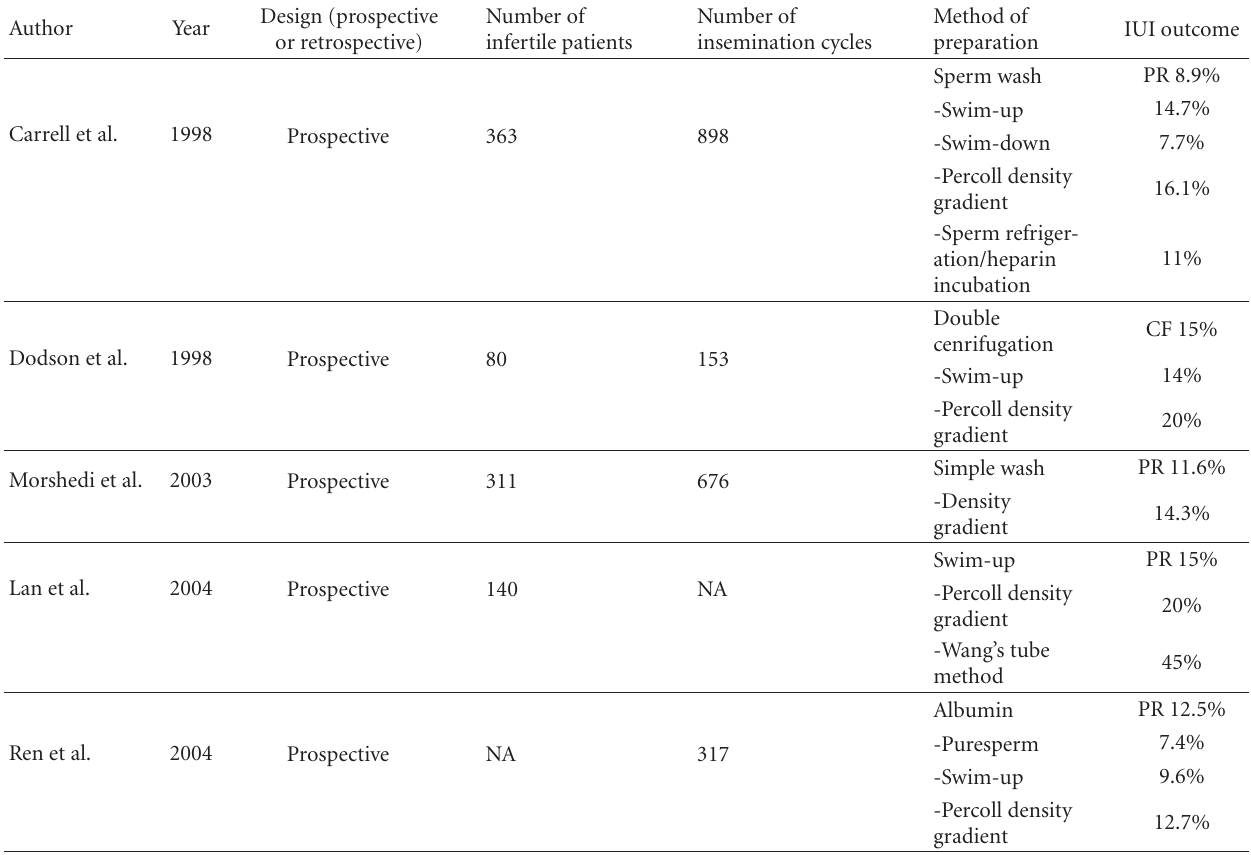
Table 2: Sperm preparation